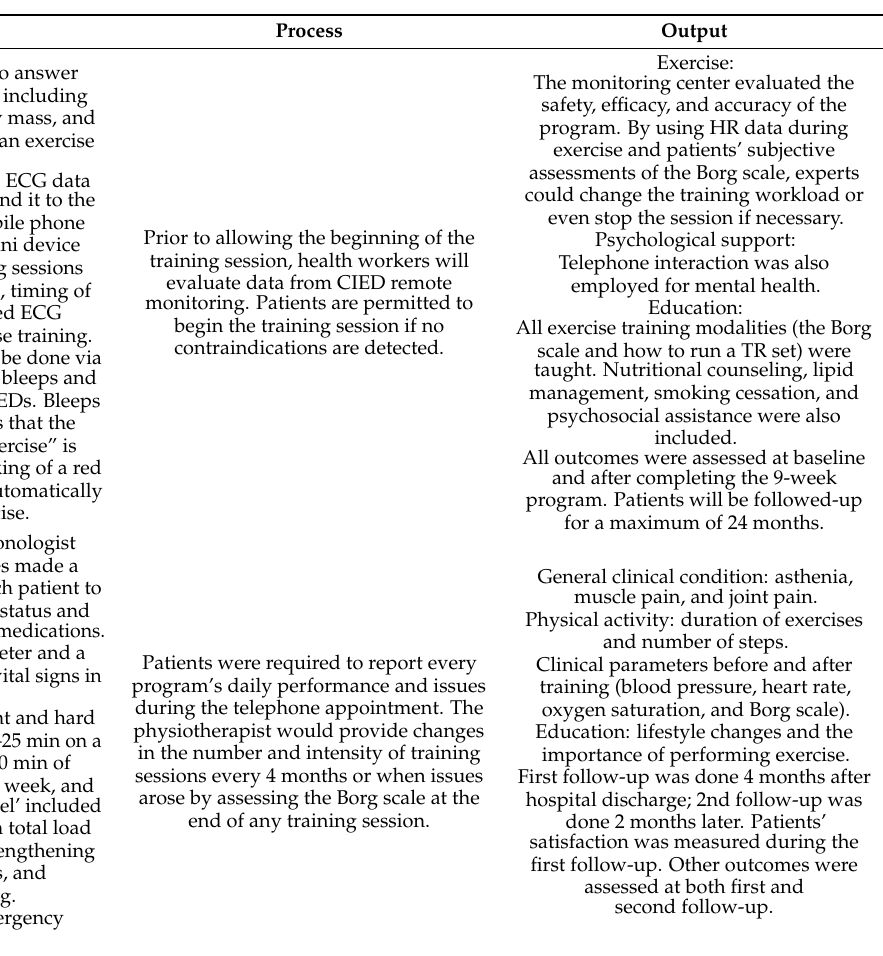
Table 2. Models of cardiac telerehabilitation for heart